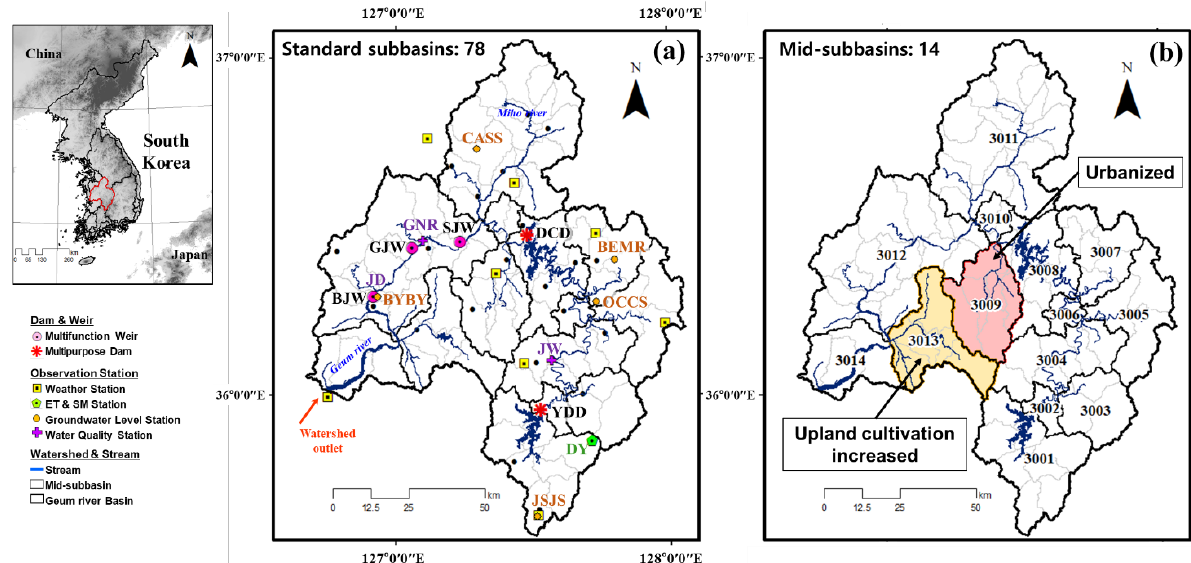
Figure 1. Locations of ( a ) the Geum River Basin’s boundaries and gauging stations for the SWAT modeling, ( b ) subbasins with increased urban and upland cultivation.